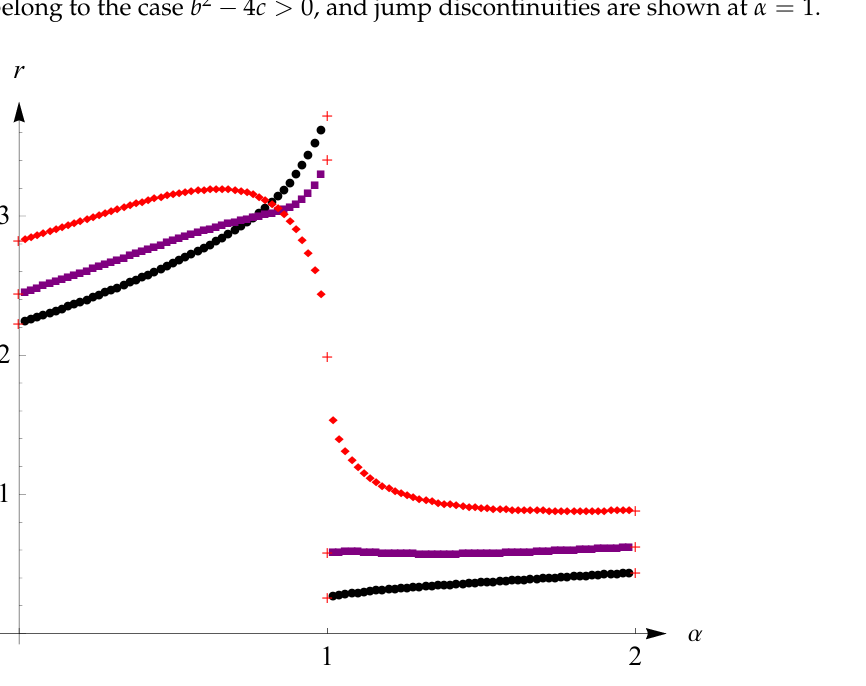
Figure 4. Curves of r ( α ) vs. α for b = 4 and for c = 1 (black circular dots), c = 2 (purple square dots) and c = 4 (red rhombic